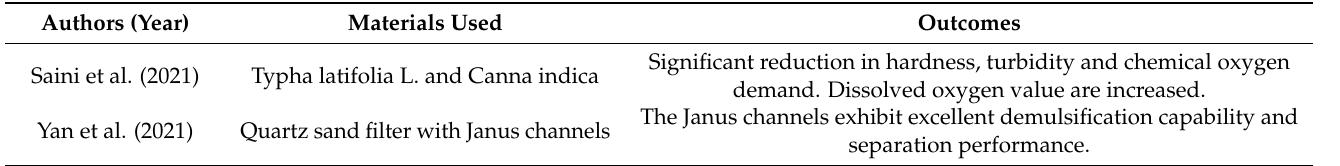
Table 2. Recent studies of sand filters for demulsification and separation oil/water